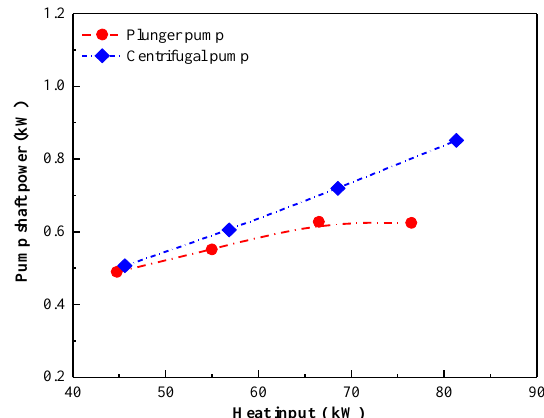
Figure 7. Pump shaft power with heat input using the plunger pump and centrifugal pump.